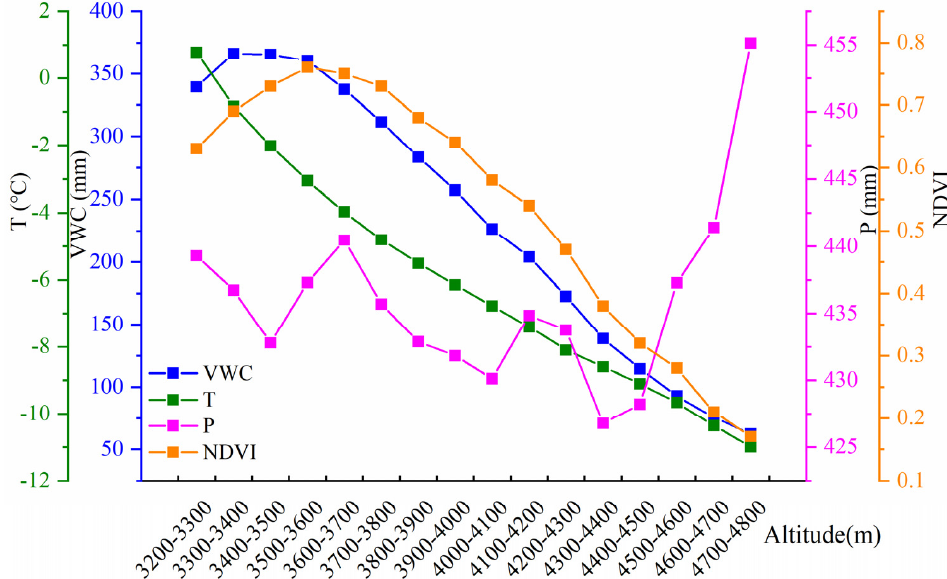
Figure 12. The VWC, annual average temperature, precipitation, and NDVI change along the altitude gradient in the Qinghai Lake Basin from 2015 to 2020.